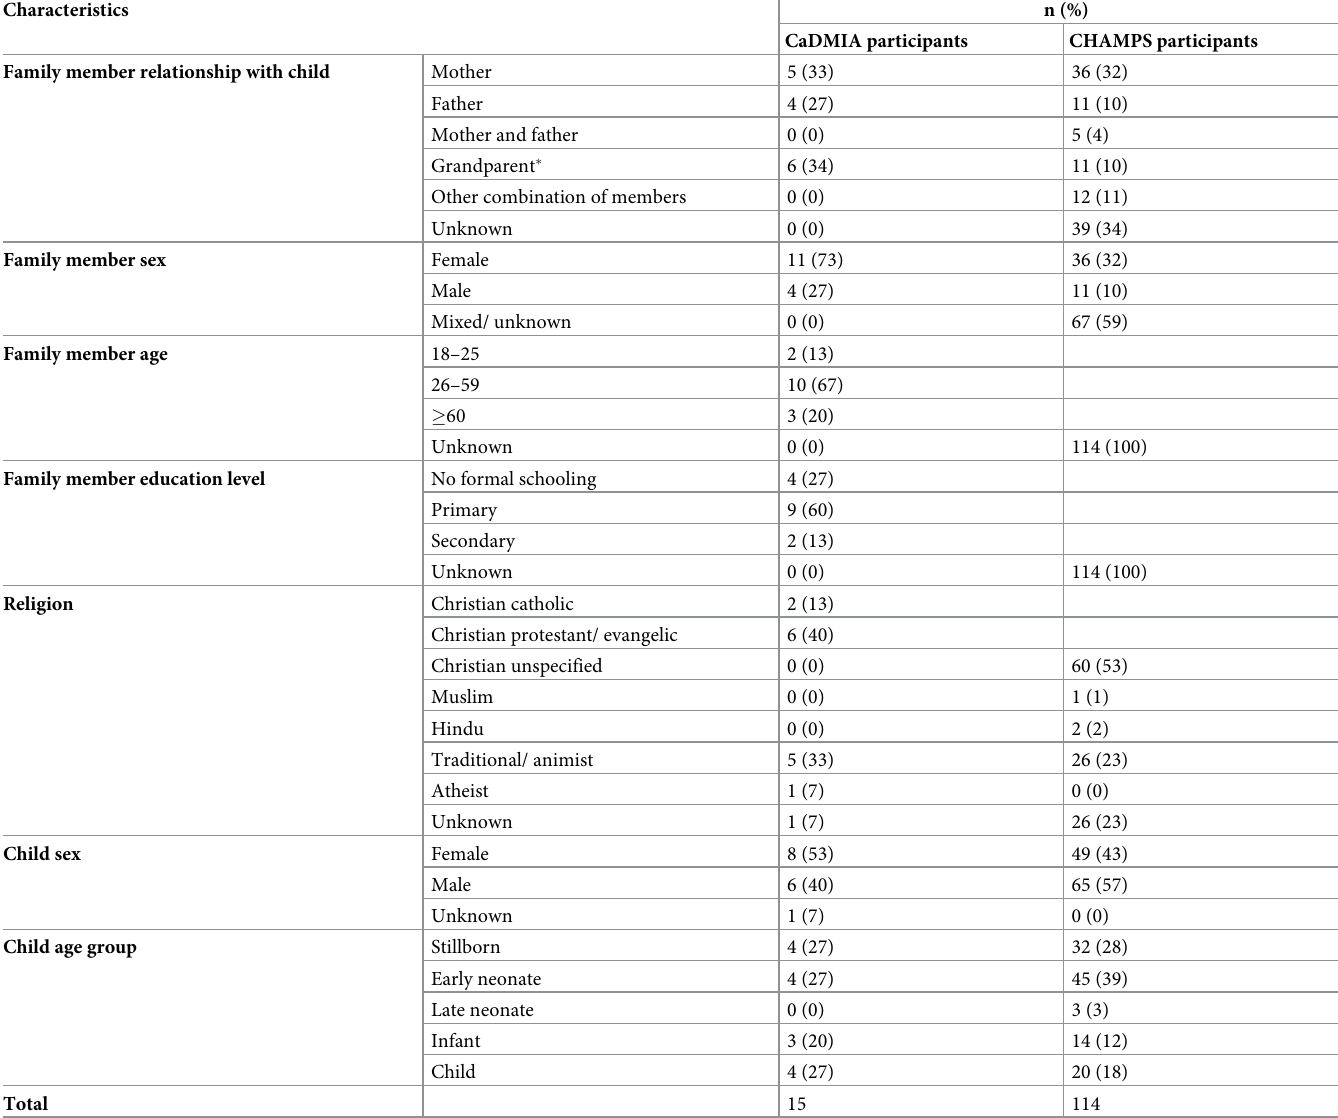
Table 1. Cases characteristics (family members and deceased children) contributing to the anticipated and experienced acceptability analysis.